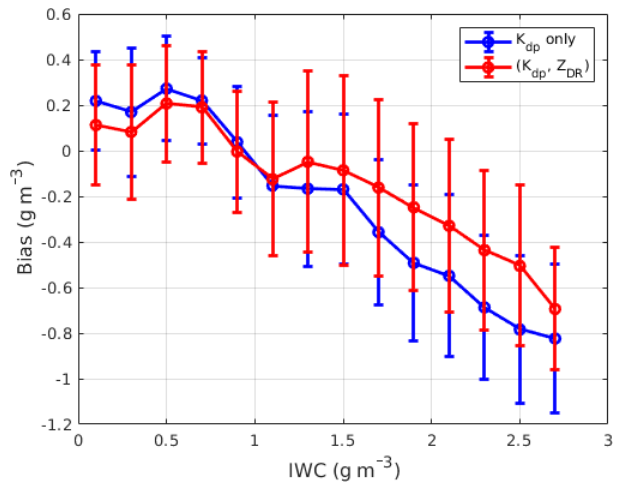
Figure 16. Bias and rms difference as a function of IWC derived from the seven selected flights. Mean values and standard deviation are computed from data points in each IWC bin of 0.2gm − 3